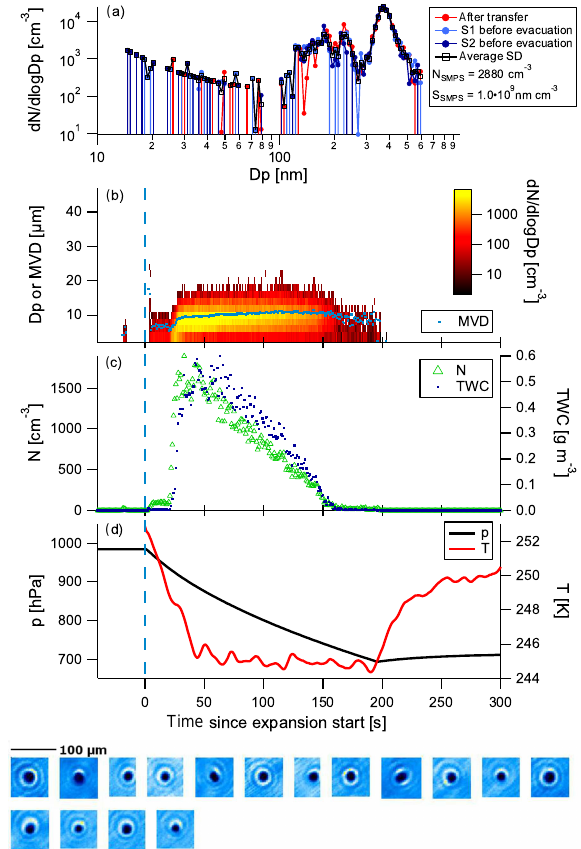
Figure 4. Example of a cloud evacuation performed on heptadecane precursor aerosol (experiment 10; see Table 1). Panel (a) shows the SMPS size distributions obtained before the expansion, followed by time series of FSSP measurements, size distribution and mean volume diameter (MVD, panel b ), total water content (TWC) and number concentration ( N , panel c ), and temperature and pressure (panel d ) during evacuation. Below the time series images captured by the CPI are shown. This was the second run on the aerosol pop- ulation with a fast pump speed.